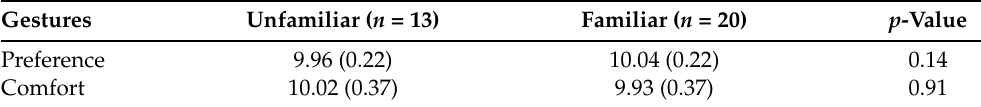
Table 5. The mean ( SD ) ratings on comfort and preference for unfamiliar and familiar gestures.